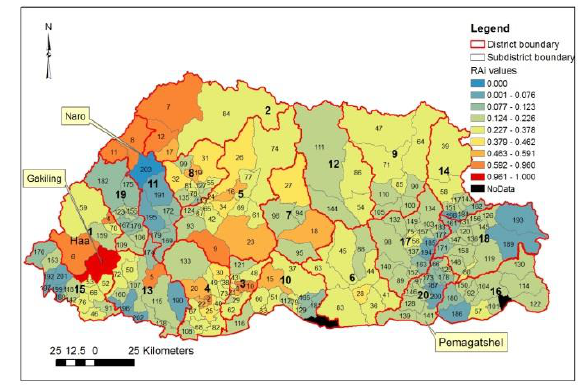
Figure 8: Districts and sub-districts accessibility ranking map for HA and